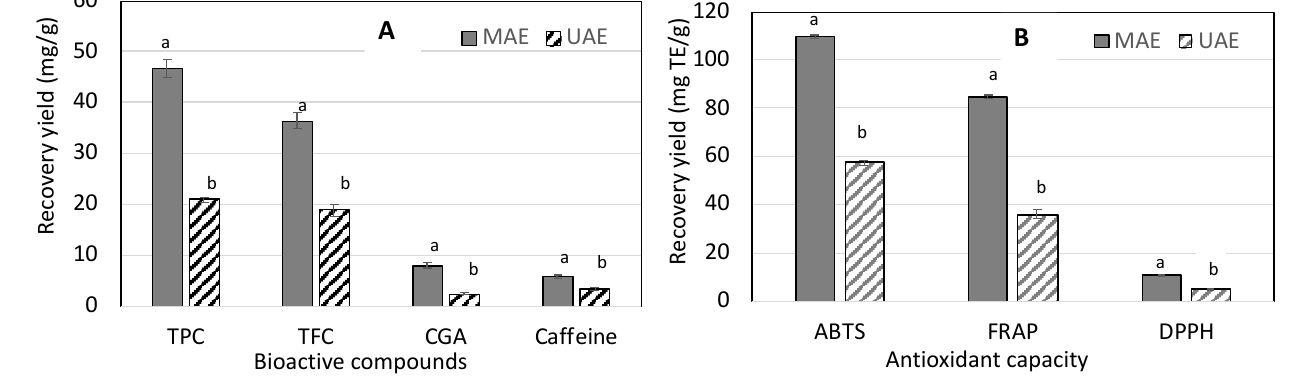
Figure 1. Comparison of MAE and UAE for recovery yields of bioactive compounds ( A ) and antioxidant capacity ( B ). Data are means ± standard deviations ( n = 3). Columns for each group not sharing similar letters are significantly different at p < 0.05.